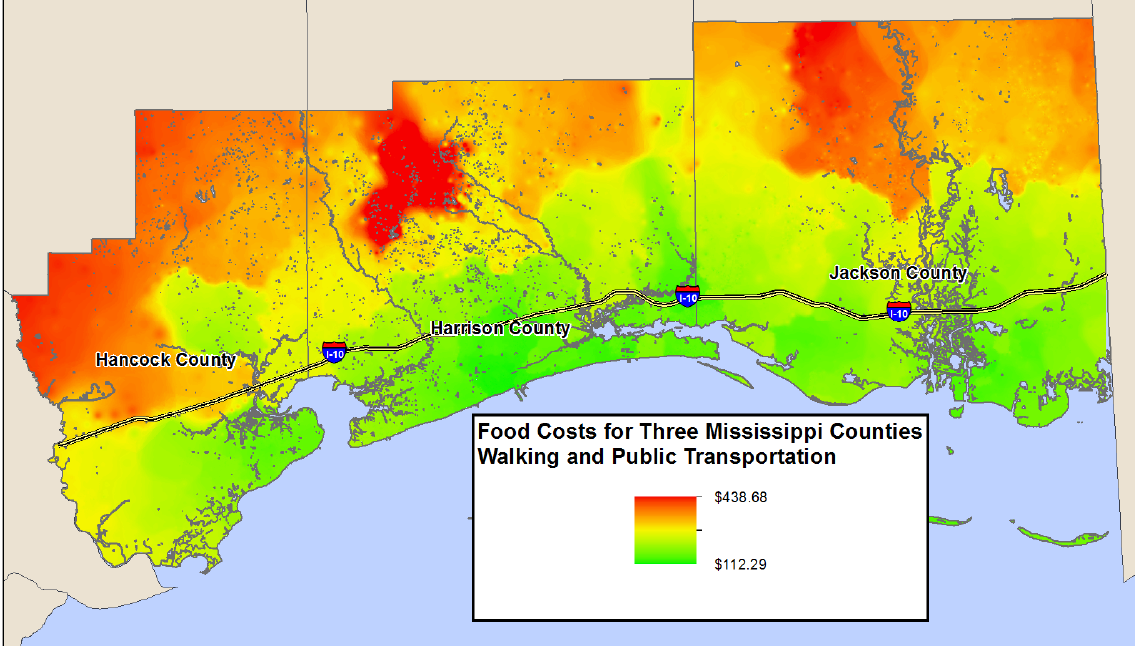
Figure 5. Map of the minimum total cost of the USDA Thrifty Food Plan in the Gulf Coast counties of Mississippi, during Spring 2011, including both the costs of the food items and transportation by a combination of walking and public transportation by bus to acquire